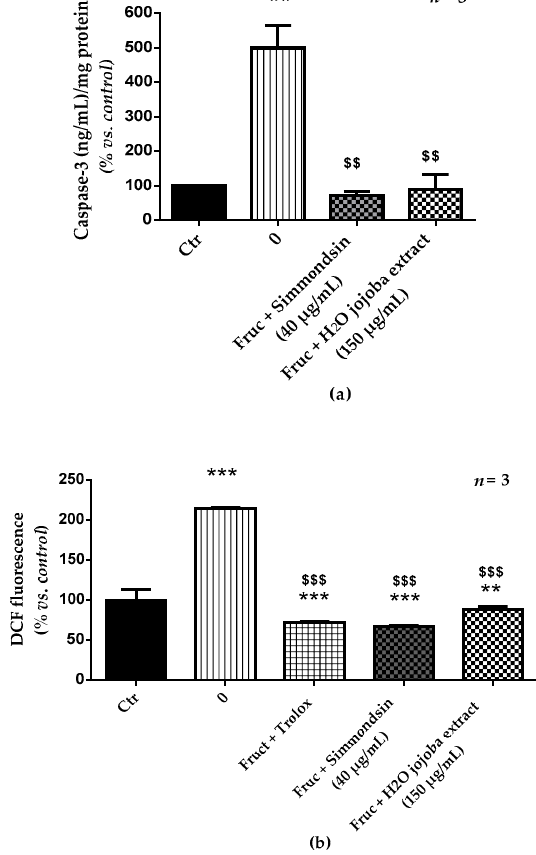
Figure 4. Effect of the aqueous jojoba seed extract and pure simmondsin on caspase-3 activation ( a ) and oxidative stress ( b ). Each value represents the mean ± standard error of the mean (SEM) of three independent experiments in triplicate. ** p < 0.01, *** p < 0.001, compared to untreated cells, $$$ p < 0.001, compared to fructose-treated cells.